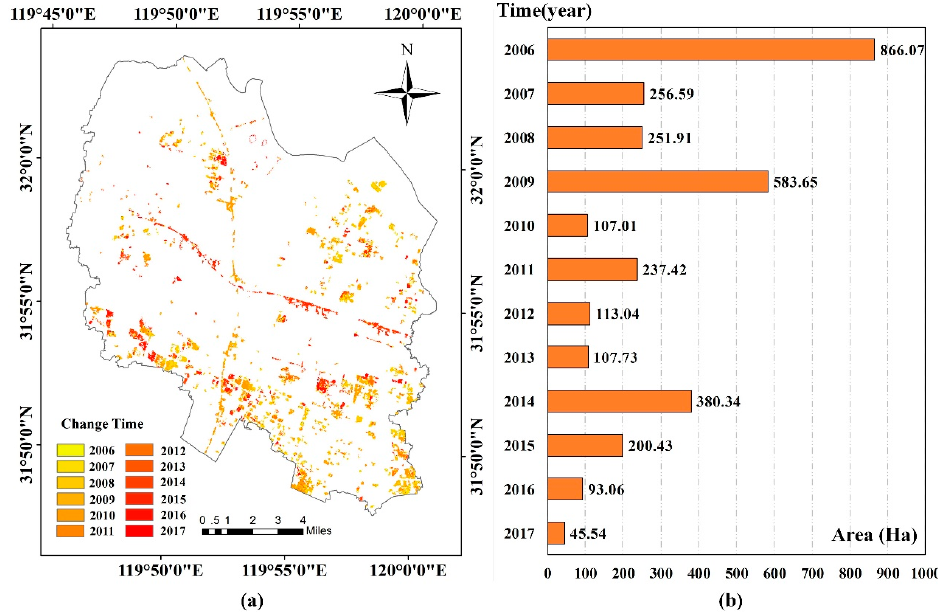
Figure 10. Spatiotemporal distribution of impervious surface expansion from 2005 to 2017. ( a ) Spatial distribution of impervious surface expansion. ( b ) Area statistics of impervious surface expansion every year.